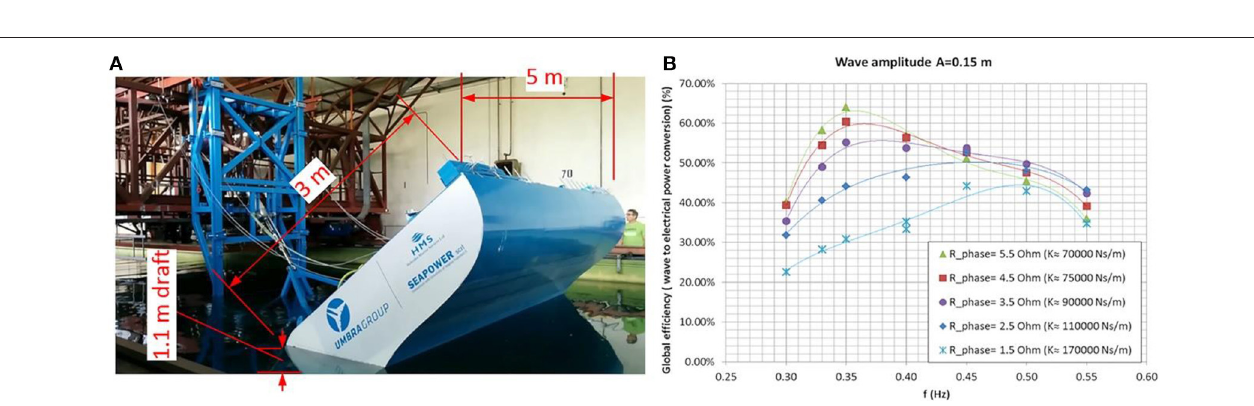
FIGURE 10 | CFD model computational grid (A) . Comparison of potential flow, CFD, and experimental results in terms of piston oscillation amplitude as a function of wave frequency with no PTO load (B) .